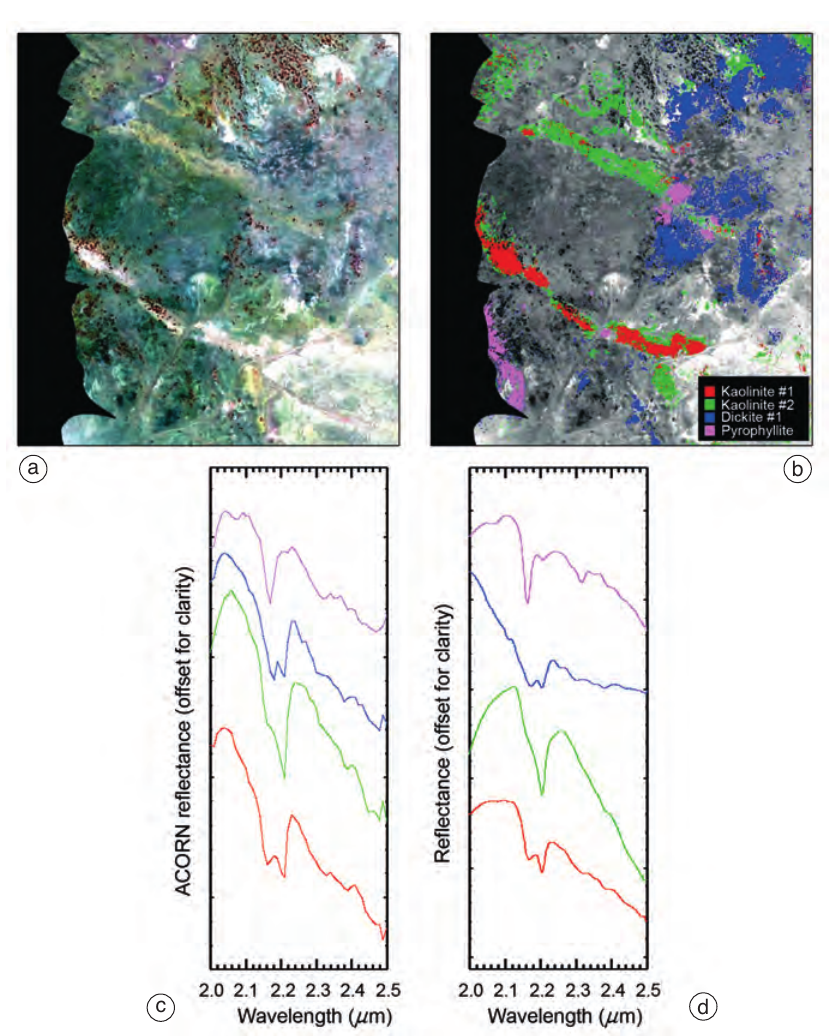
Fig. 5a-d. Geocorrected Pyophyllite Discovery AVIRIS results. a) False Color Infrared composite (CIR) image of bands 31, 19, 9 (0.66, 0.55, 0.45 n m) as RGB. b) SWIR mineral mapping results. Note pyrophyllite occur- rence in center of image crosscutting northwest-trending kaolinite distributions. c) AVIRIS endmember spectra: red is well crystalline kaolinite, green is poorly crystalline kaolinite, blue is dickite, and orchid is pyrophyllite. d) ASD field spectra for mineral occurrences mapped using AVIRIS. Colors are the same as for the AVIRIS end-